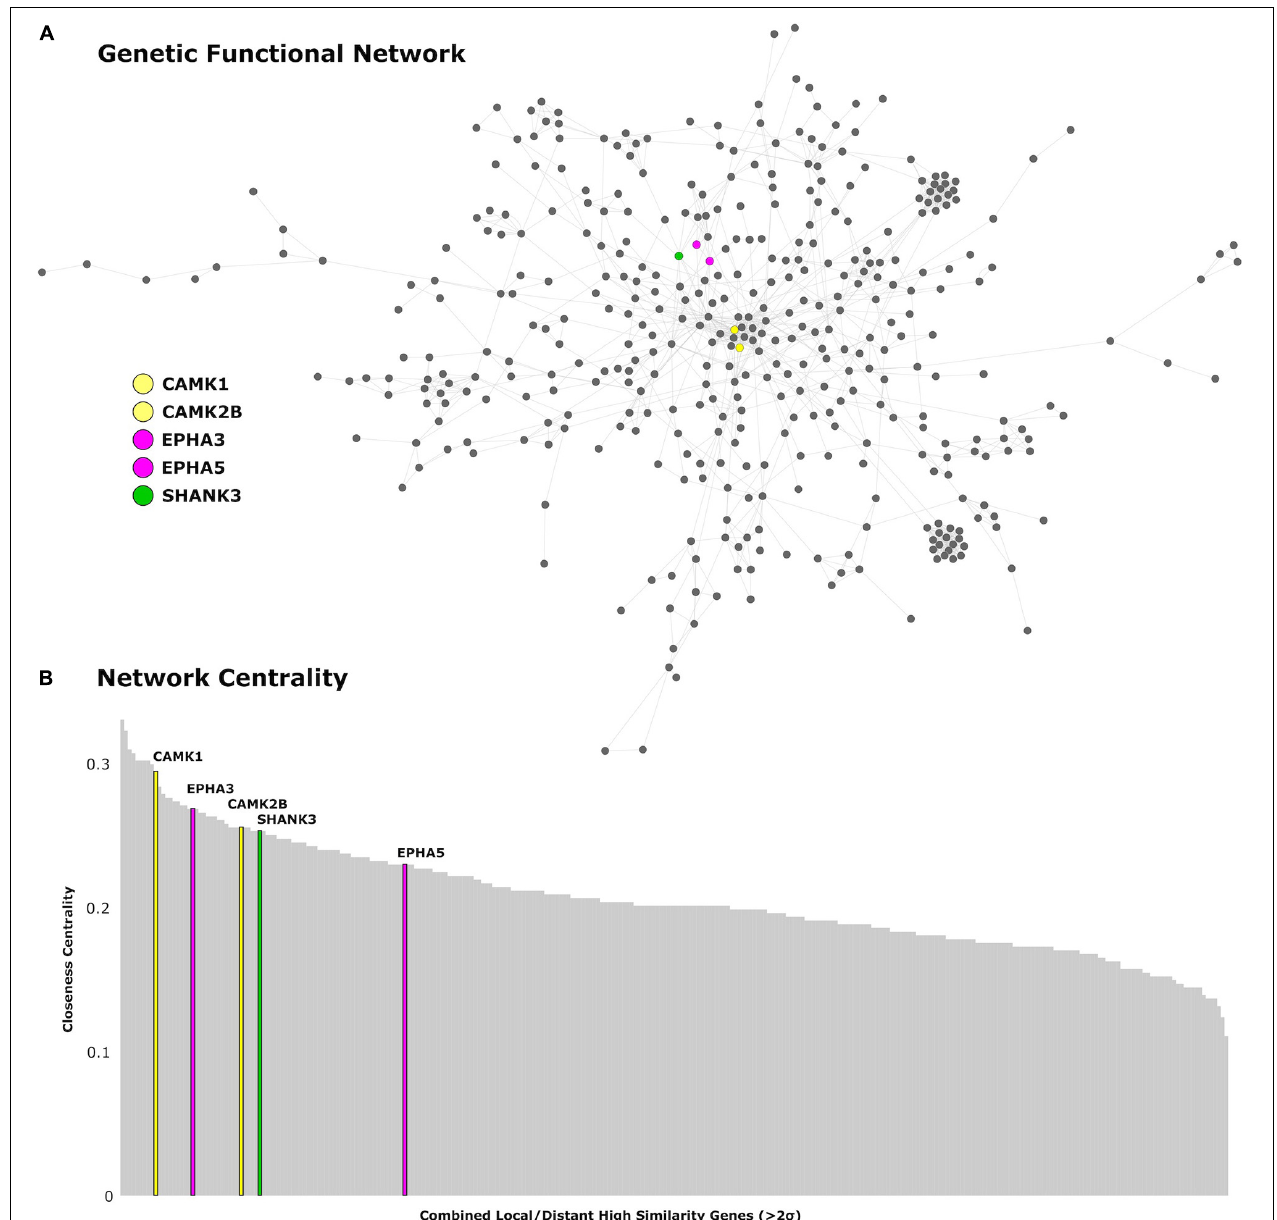
FIGURE 5 | Genetic network analysis. (A) Protein-coding genes from the AHBA with high cortical expression within the local and distributed networks ( > 2 SDs) are presented in the network topological space. (B) Genes are plotted as a function of the closeness centrality in the network. Genes related to synaptic plasticity and post-synaptic assembly are highlighted in corresponding colors. CAMK1 and CAMK2B genes are represented in yellow, EPHA3 and EPHA5 are represented in magenta, and SHANK3 is represented in green.